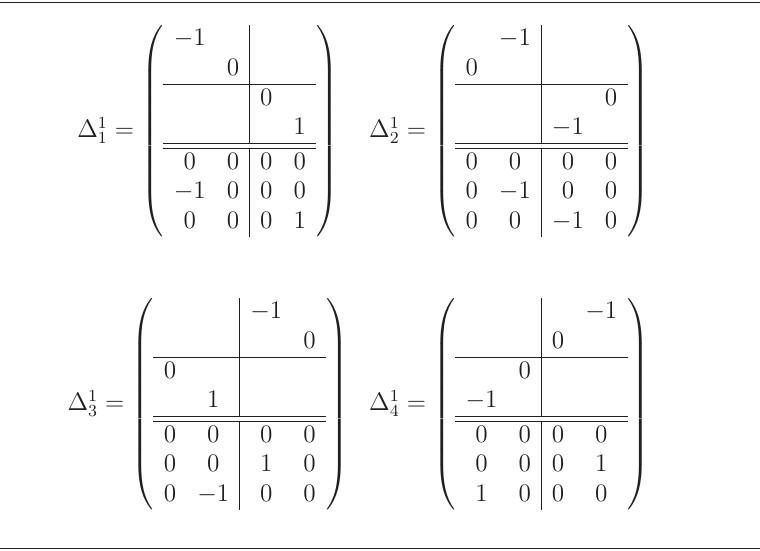
Table 8: The 1-sector space-like down matrices for the Maxwell field-strength